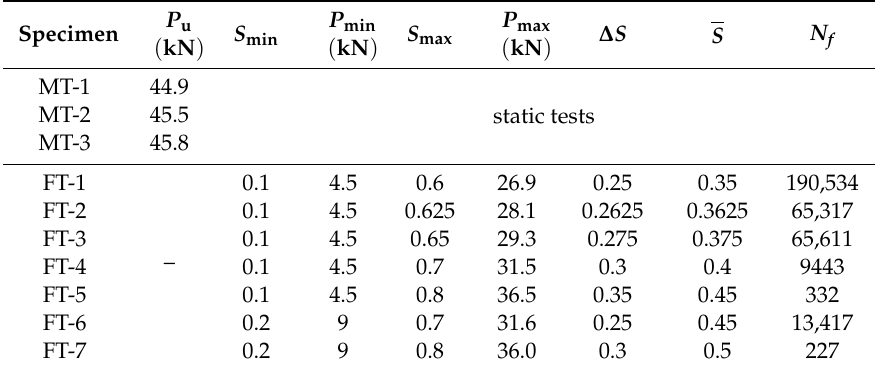
Figure 5. Failure mode of the fiber reinforced polymer (FRP)–concrete joint under static load. Table 3. Failure loads and cycles of monotonical and fatigue tests.